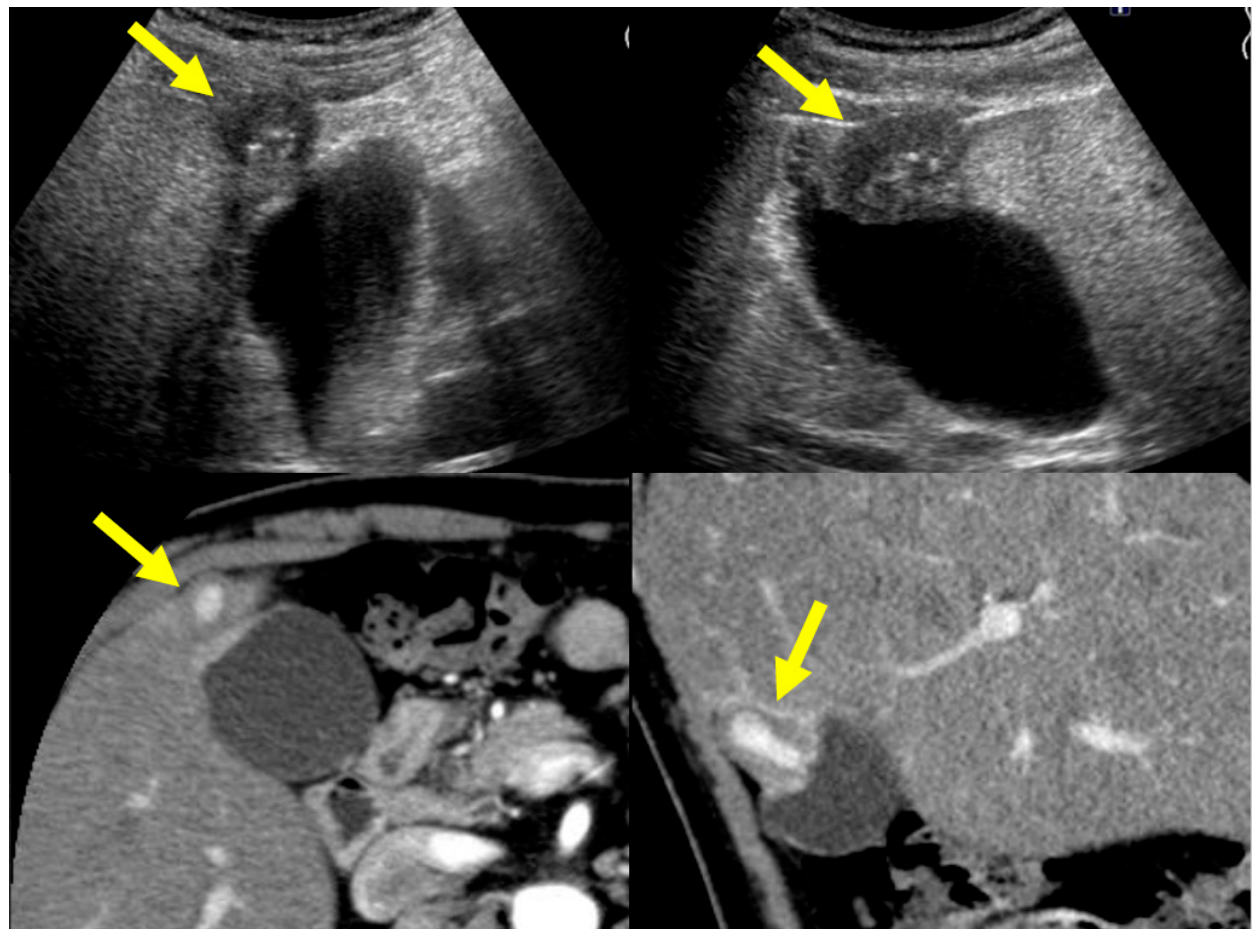
Figure 8. US (protruding type A) and CT (protruding type A) findings of a case with a localized type of IgG4-sclerosing cholecystitis (arrows).